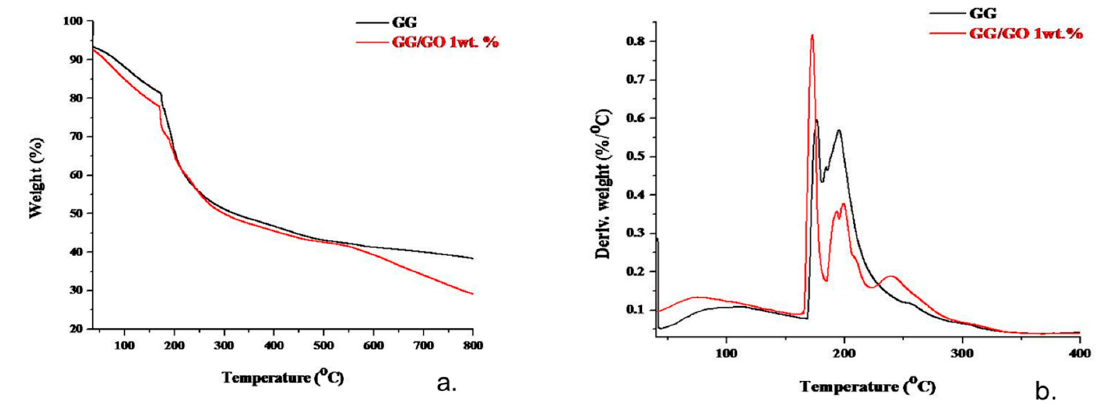
Figure 4. TGA ( a ) and DTG ( b ) curves of GG and GG / GO hydrogel composite beads.